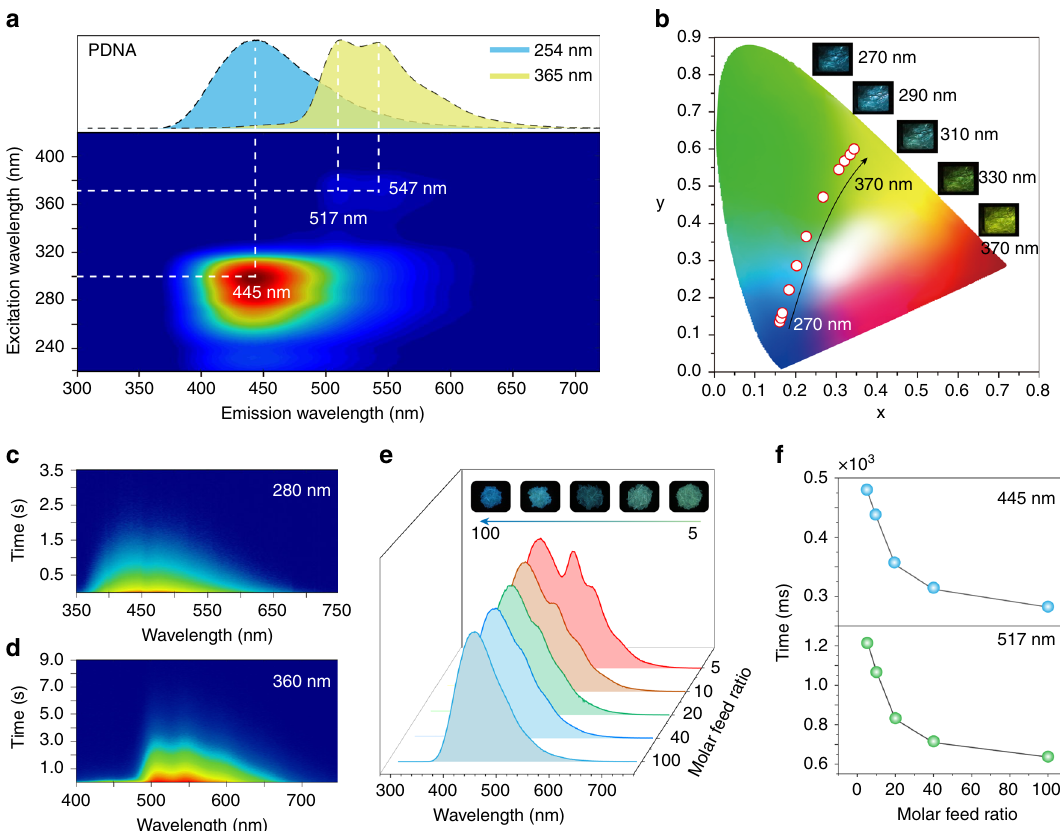
Fig. 2 Photophysical properties of multicomponent copolymer at room temperature. a Excitation – phosphorescence mapping of polymer fi lm PDNA under ambient conditions. The inset displays the phosphorescence spectra of the transparent fi lm recorded at room temperature excited by 254 nm (blue) and 365 nm (yellow). b CIE chromaticity diagram for polymer PDNA with excitation varied from 270 to 370 nm. Inset: long-lived luminescence photographs of polymer fi lm PDNA excited at 270, 290, 310, 330 and 370 nm, respectively. c , d Time-resolved emission spectra of PDNA at room temperature upon excitation at 280 and 360 nm, respectively. e Normalized phosphorescence spectra and the ultralong phosphorescence photographs (inserted images) of multicomponent copolymers with different molar feed ratio of MND:MDP:AA = 1:5:1000 (PDNA-5), 1:10:1000 (PDNA-10), 1:20:1000 (PDNA-20), 1:40:1000 (PDNA-40), and 1:100:1000 (PDNA-100) excited at 254 nm. f Phosphorescence lifetime of PDNA with different molar feed ratios of PDNA-5, PDNA-10, PDNA-20, PDNA-40, and PDNA-100 at 445 (top) and 517 nm (bottom) when excited at 254 and 360 nm at room temperature,